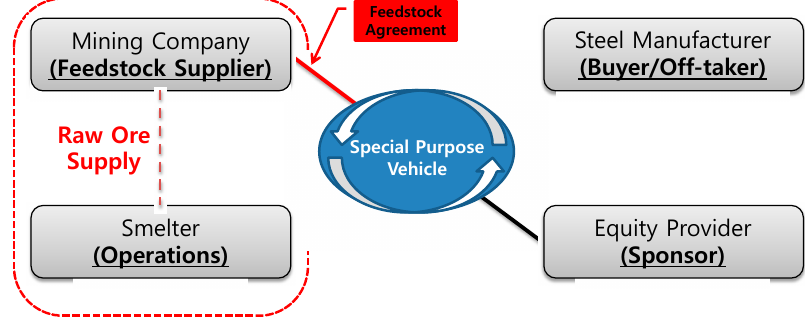
Figure 1. SPC stakeholders’ interactions and agreements.